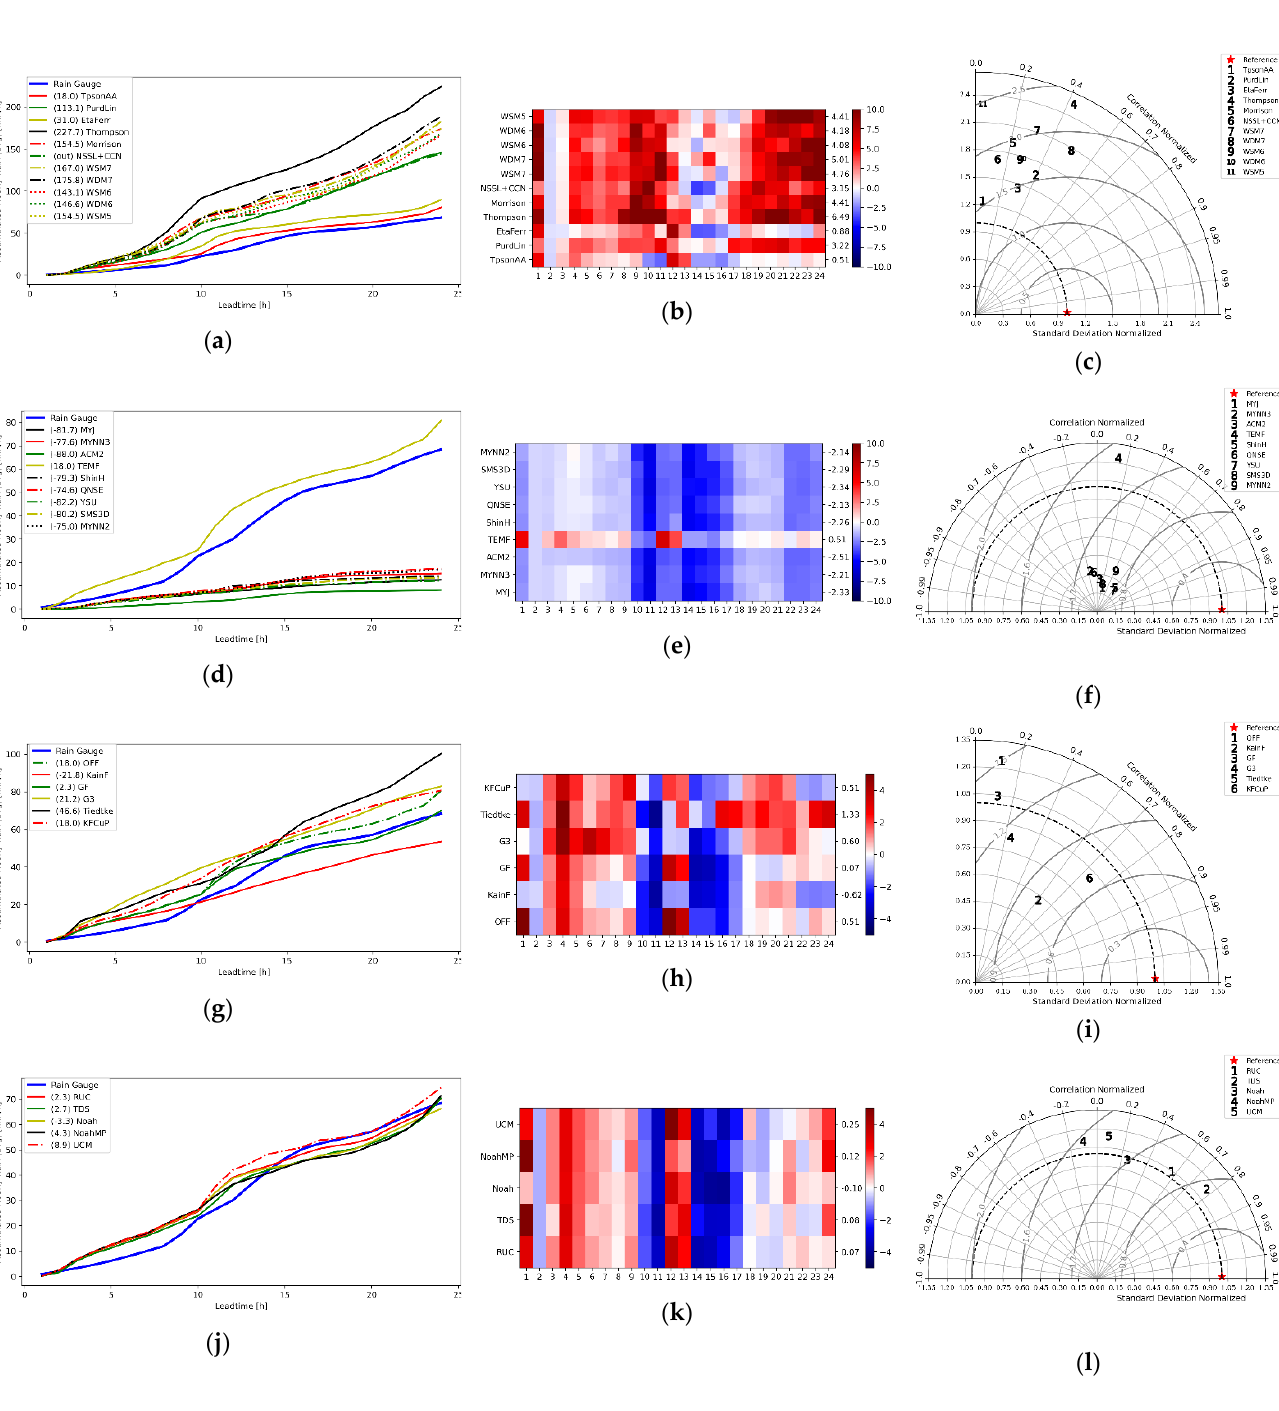
Figure 8. As in Figure 4 but for event 5. Table 3 summarizes the best configurations and metrics obtained for each analyzed event, and Table 4 presents the variations in REs among each set of physical schemes tested and the best RE achieved. Table 3. The best settings and their respective statistical metrics.